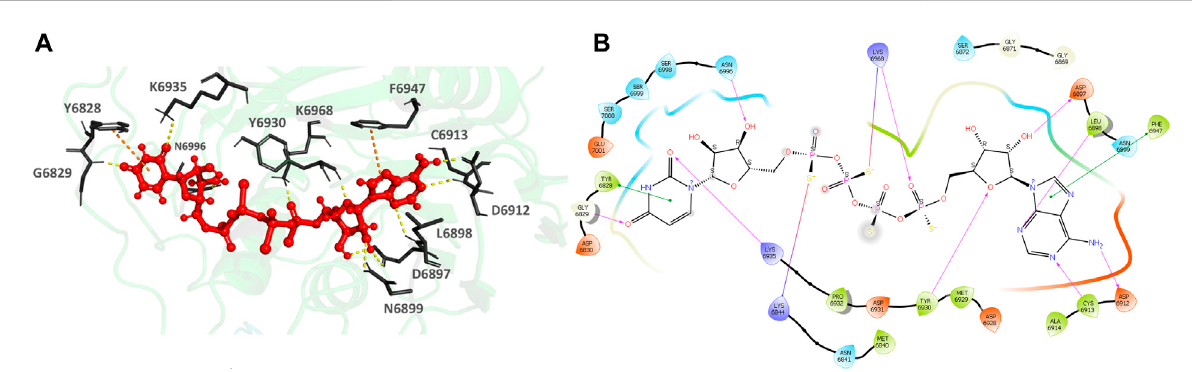
FIGURE 9 The different POOL-predicted sites for the SARS-CoV-2 Nucleocapsid protein. POOL-predicted sites for the full-length SARS-CoV-2 Nucleocapsid protein built on I-TASSER. (A) Site 1 shown in blue, (B) Site 2 in green and (C) Site 3 in